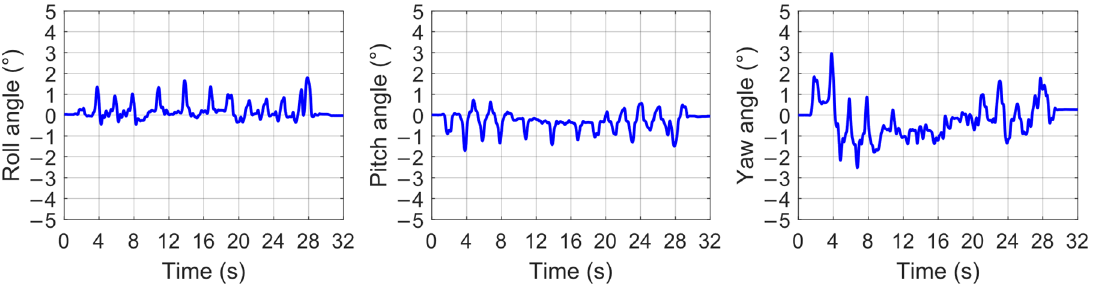
Figure 19. Attitude variations in the experiment of gait transformation.